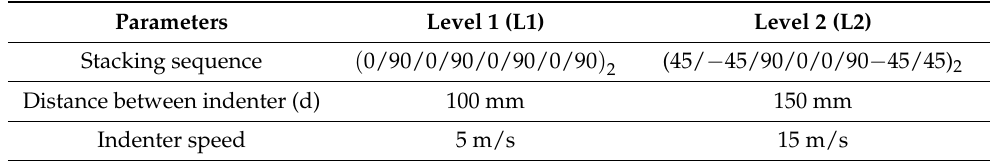
Table 2. Parameters studies through four-point bend